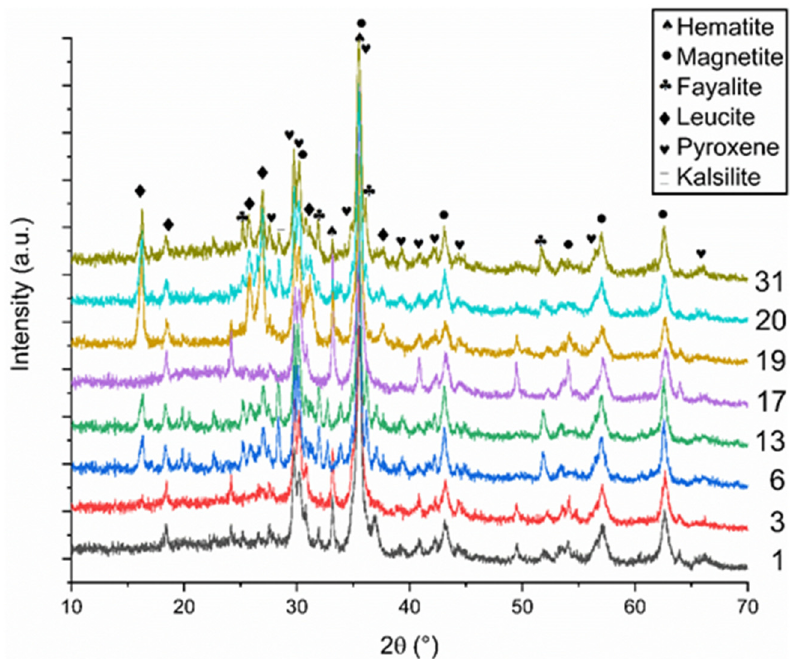
Figure 13. X-ray diffractogram of the samples of run 1, 3, 6, 13, 17, 19, 20, and 30 after firing to 900 °C for 2 h.